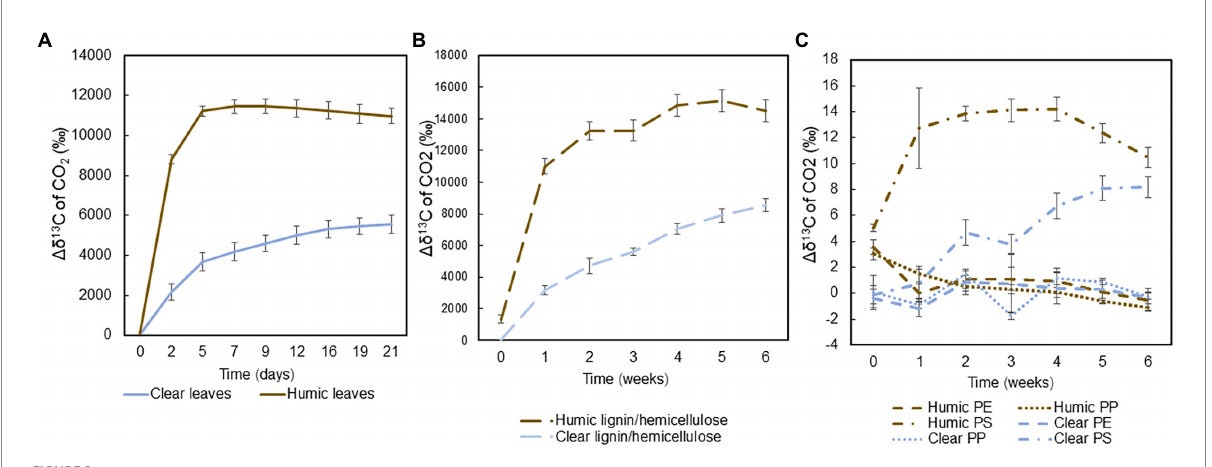
FIGURE 2 Averages and standard deviations of the mineralization of 13 C-labeled (A) leaves ( n = 4), (B) lignin-hemicellulose substrate ( n = 4), and (C) microplastics during the experiments ( n = 4) were calculated by subtracting average δ 13 C value of the control group from the δ 13 C of each